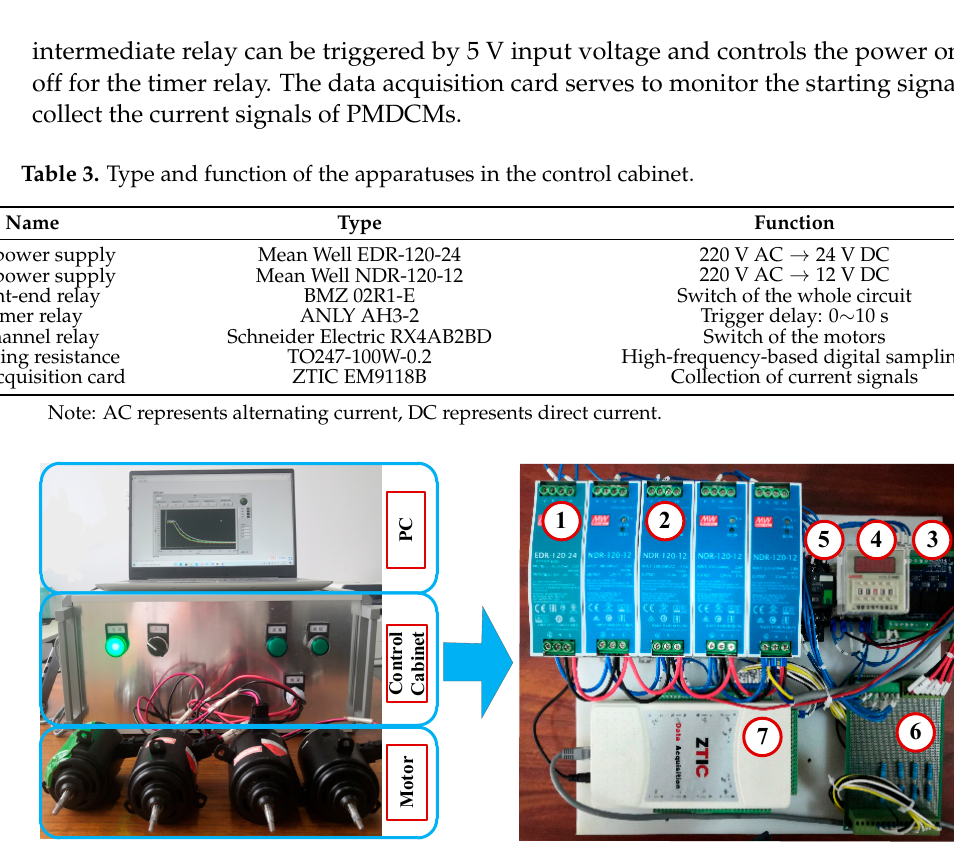
Table 3. Type and function of the apparatuses in the control cabinet.